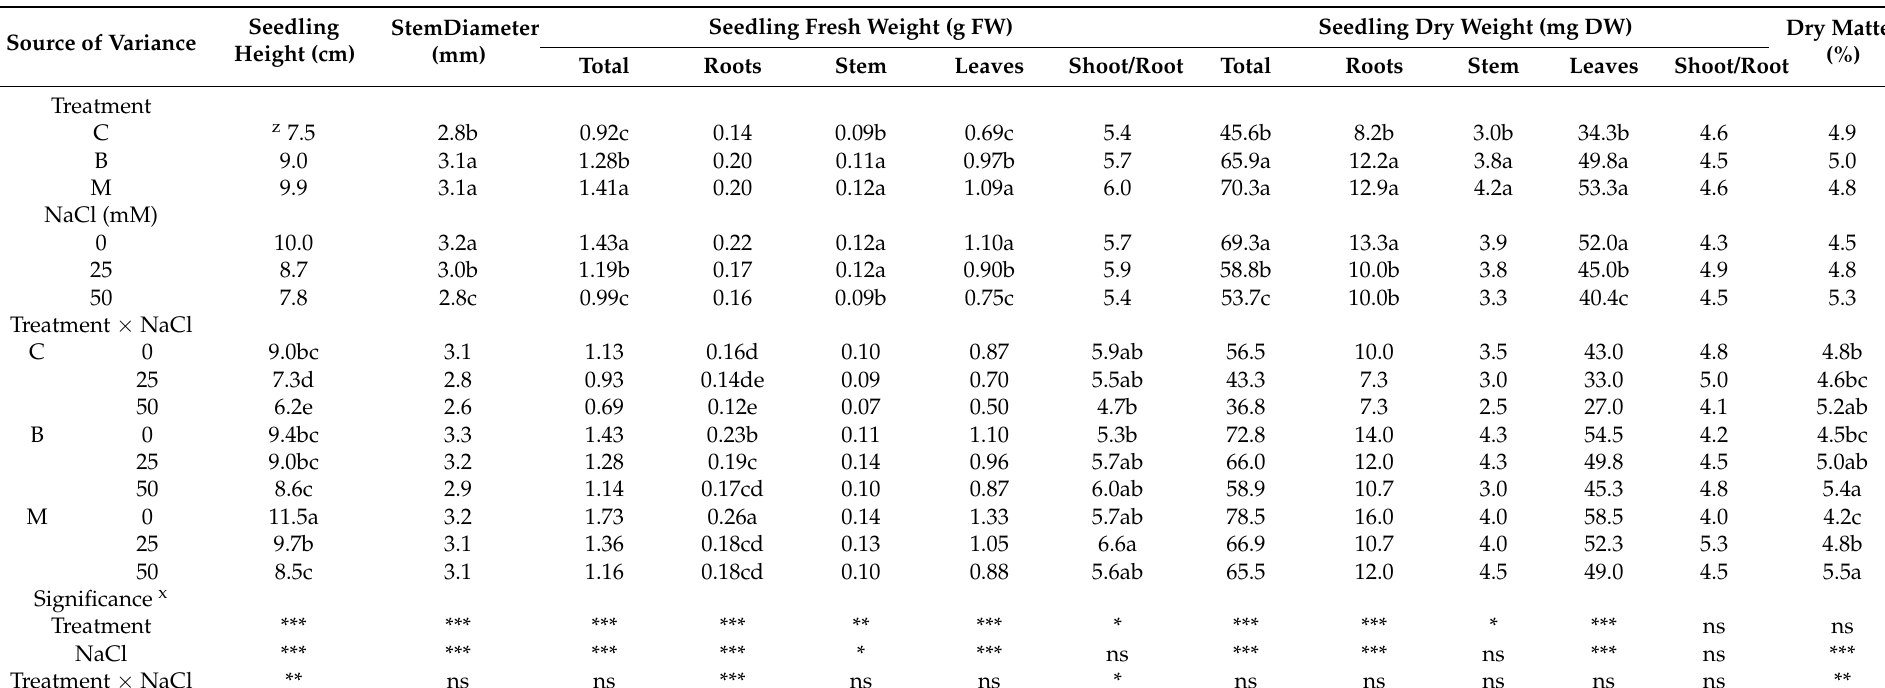
Table 1. Effects of microbial biostimulant treatments (C, not treated; B, Bactorr S13 ; M, Flortis Micorrize) and salt stress (0, 25, and 50 mM NaCl in the irrigation water) on morphological parameters of lettuce